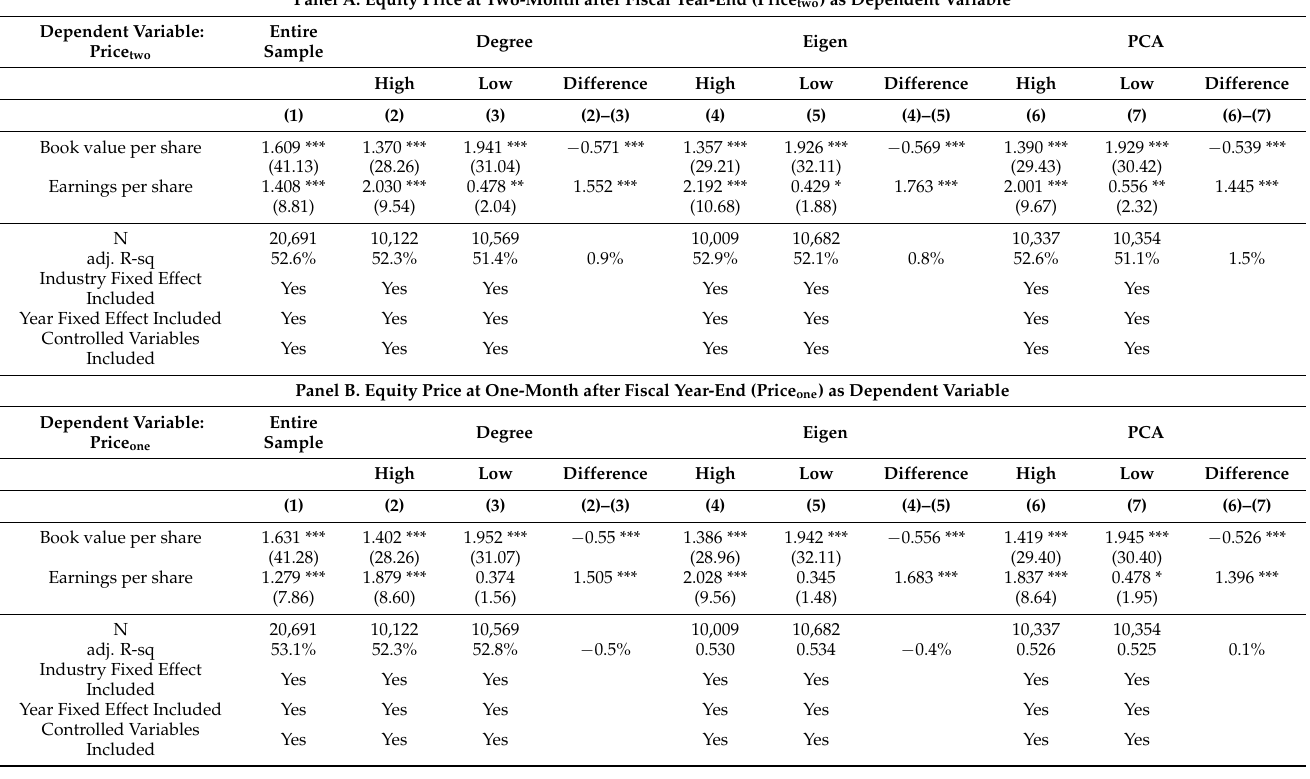
Table 4. Alternative Measures of equity price. This table presents the results of the OLS regressions explaining the effect of CEO social capital on the value relevance of book value of equity and earnings metrics based on different equity prices as the dependent variable. In Panels A, B and C, the dependent variables are Price two , Price one and Price year-end , which are continuous variables measured by the market price of the common equity at the end of two months after fiscal year-end, at the end of one month after fiscal year-end and at the fiscal year-end, respectively. CEO social capital is measured by Degree in columns (2) and (3), Eigen in columns (4) and (5) and PCA in column (6) and (7); variables of interest in the regression include Book value per share (book value of common equity scaled by number of shares outstanding) and Earnings per share (net income scaled by number of shares outstanding). All regressions include control variables as defined in Appendix A. For brevity, the table only presents coefficients related to the variables of interest. All regressions include time- and industry-fixed effects and the errors are robust to firm heteroscedasticity. T-values are reported in parentheses. Statistical significance of the coefficients is designated as ***, ** and * at 1%, 5% and 10% levels, respectively. Panel A. Equity Price at Two-Month after Fiscal Year-End (Price two ) as Dependent Variable